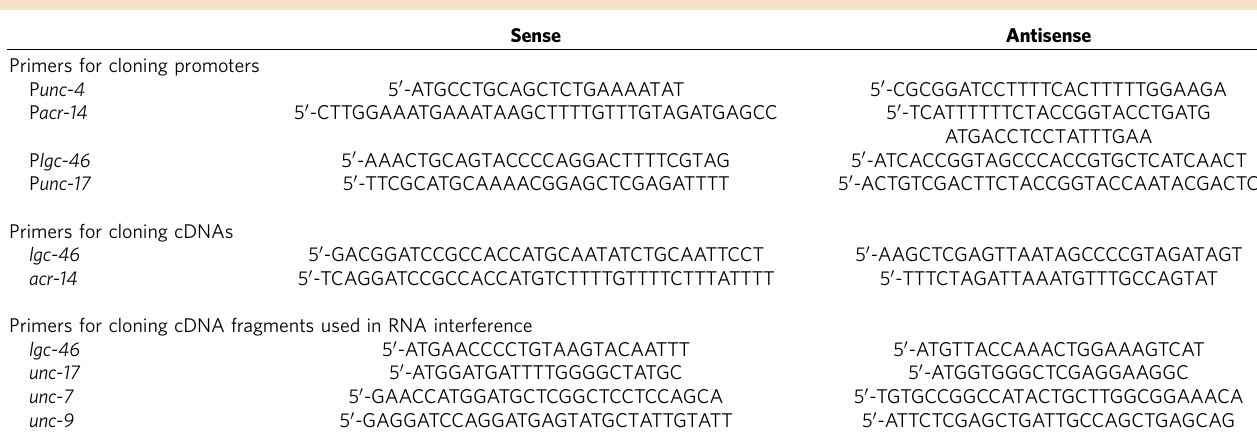
Table 2 | List of